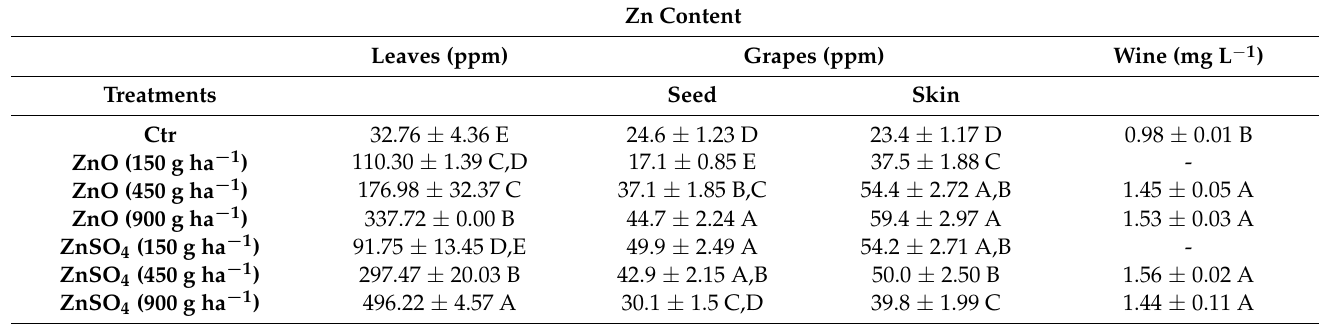
Table 2. Mean values ± SE (n = 3) of Zn concentration of Vitis vinifera L. variety Fern ã o Pires in the leaves after the 3rd foliar application, as well as in the seed and skin of grapes at harvest and in the produced wine. Letters A, B, C, D, and E indicate significant differences within the same column and variety (statistical analysis using the single-factor ANOVA test, p ≤